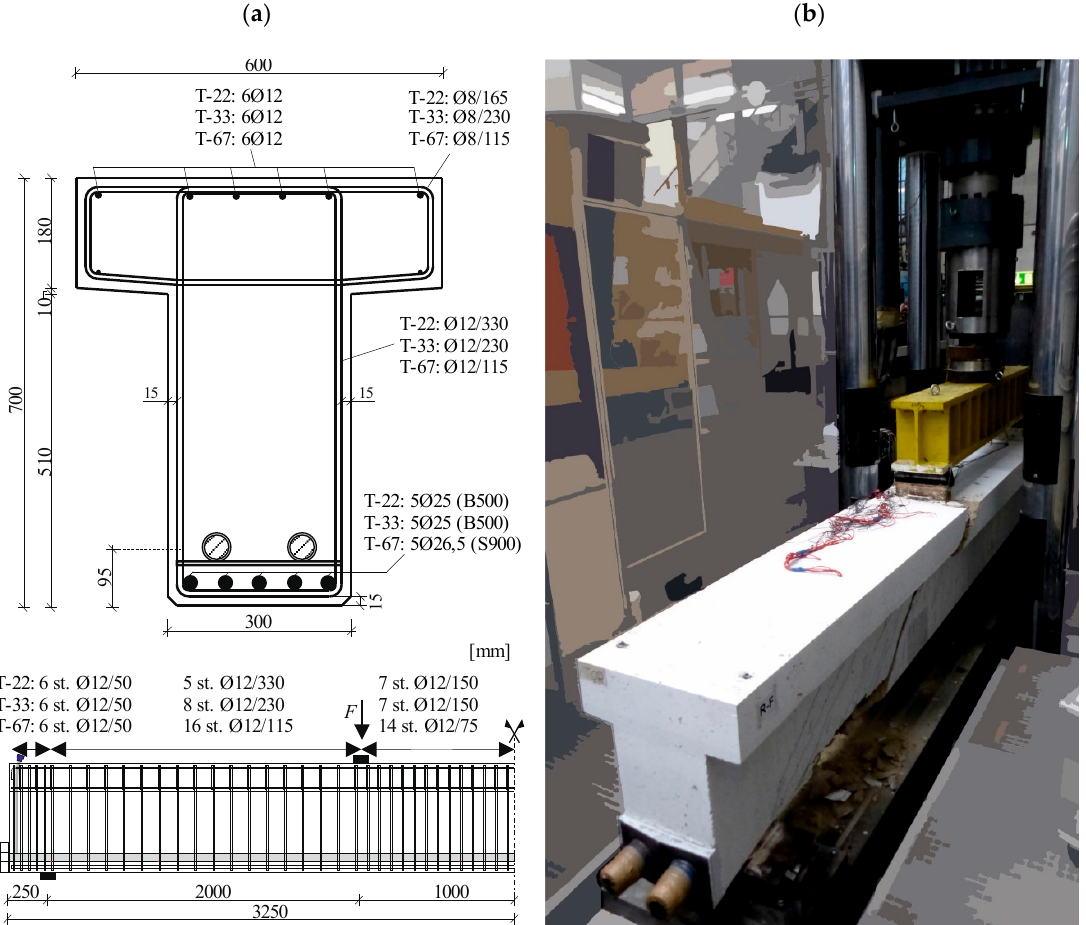
Figure 2. ( a ) Cross-section with reinforcement and longitudinal section with reinforcement; ( b ) Test setup. With an axial distance of 9.5 cm from the bottom side of the beam, two straight tendons (each 3Ø0.6” (1.4 cm 2 )) were arranged for post-tensioning (St 1570 / 1770, f p0.1k = 1500 N / mm 2 ). After the subtraction of all losses, the prestressing force for the beams varied between 330 kN and 500 kN (Table 1). The mean strengths of the ready mixed concrete during the test period were in a range of 32 and 48 N / mm 2 over all tests with a small variation over the test period of each beam (Table